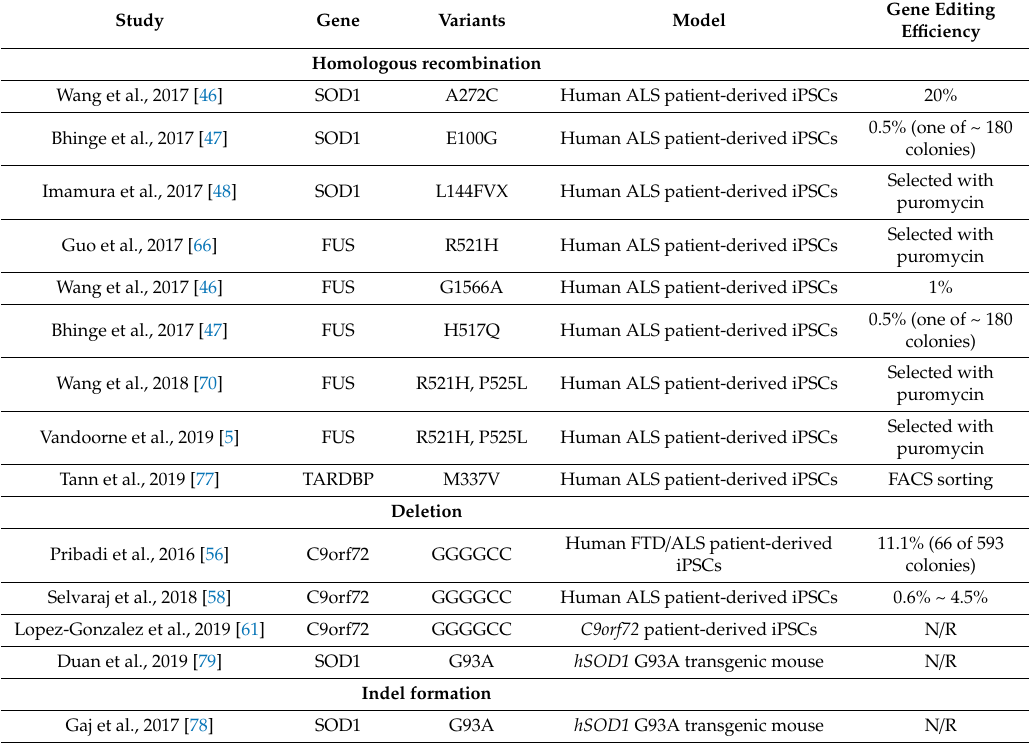
Table 2. Studies of clustered regularly interspaced short palindromic repeats / CRISPR-associated system 9 (CRISPR / Cas9)-mediated genome editing in amyotrophic lateral sclerosis. N / R, not recorded;